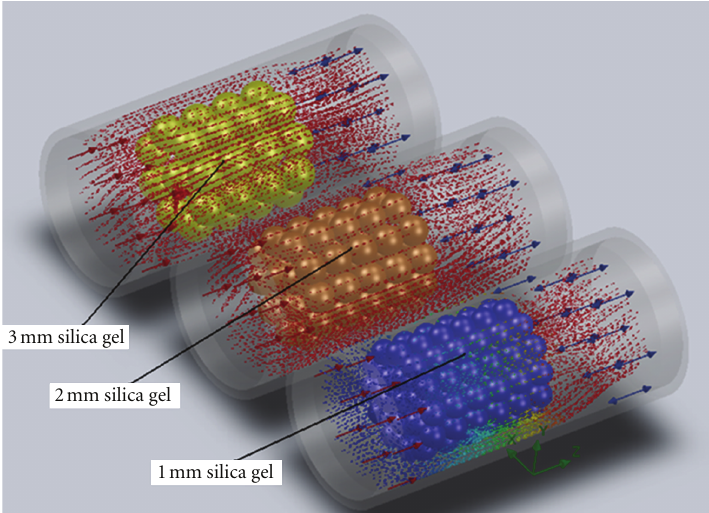
Figure 10: Flow profile in an adsorber test beds.